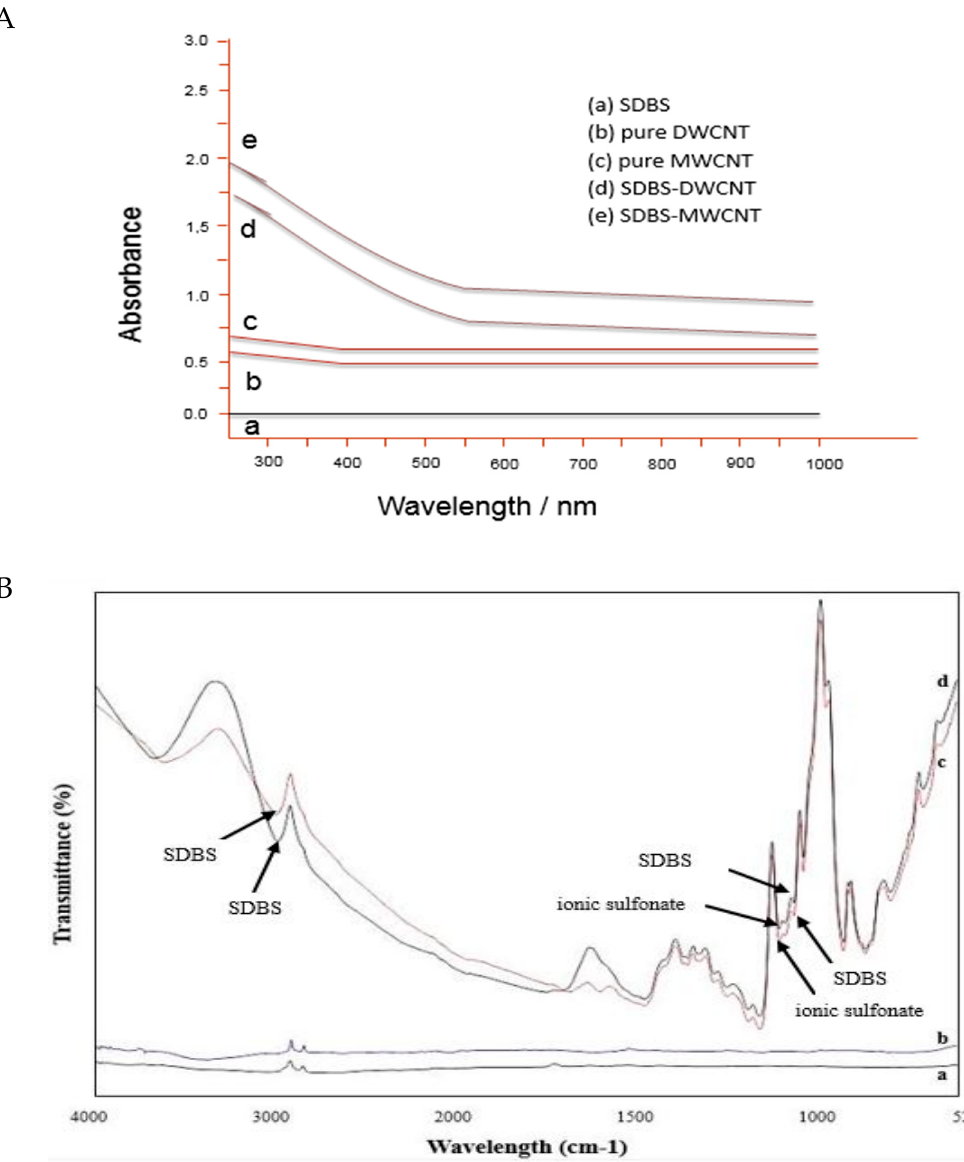
Figure 3. Carbon nanotubes suspension ( a ) sonication of multi-walled carbon nanotubes (MWCNTs) in distilled water (DW), ( b ) sonication of MWCNTs in surfactant (SDBS), ( c ) sonication of double- walled carbon nanotubes (DWCNTs) in DW, and ( d ) sonication of DWCNTs in surfactant (SDBS) for 30 min.